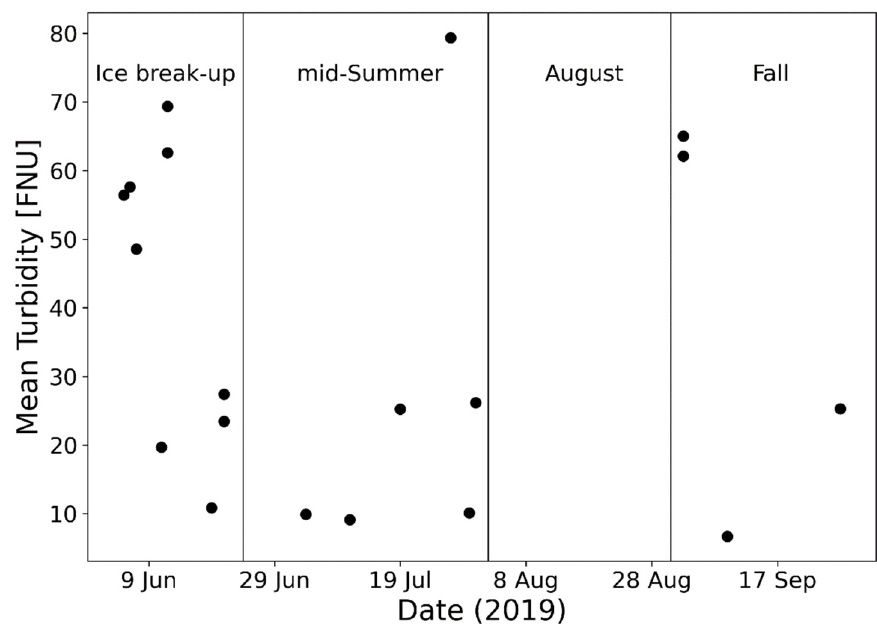
Figure 3. Overview of mean turbidity in the area of interest over the summer season 2019.